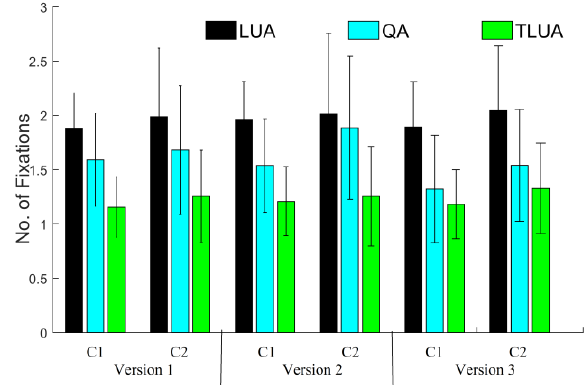
Fig. 15 Average number of fixations in LUA, QA and TLUA for 3 different dDSST versions and 2 age groups